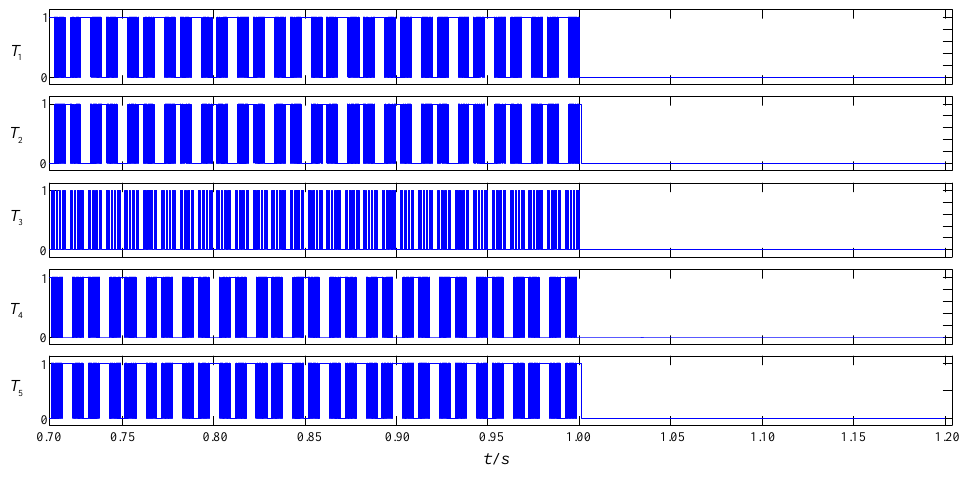
Figure 9. Switch tubes conduction situation .